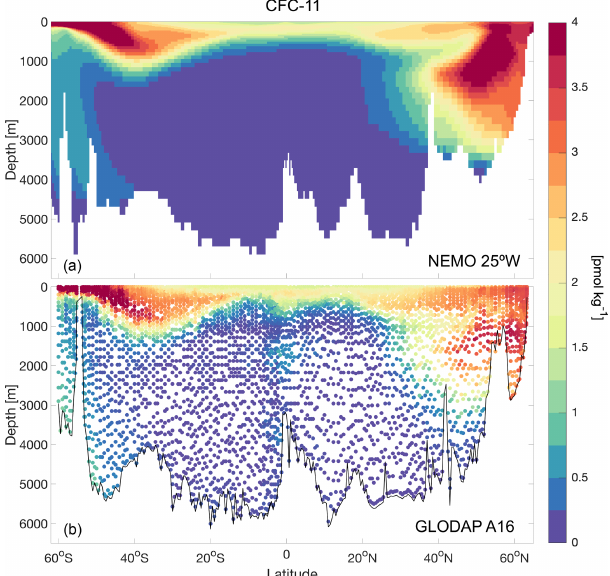
Figure 2. CFC-11 distribution in the model along a mid-Atlantic section at 25 ◦ W (a) , and observations from the Global Ocean Data Analysis Project (GLODAP) dataset along the WOCE/GO-SHIP A16 line (b)